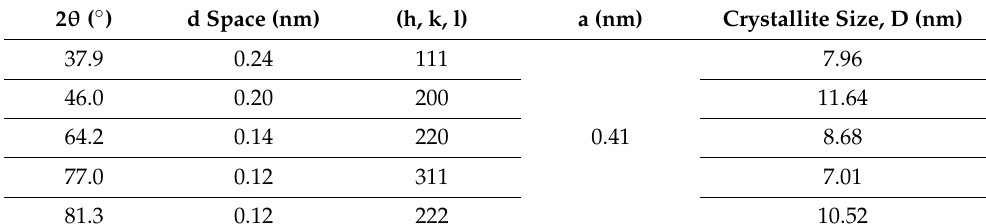
Table 1. XRD crystallographic data of the AP-AgNPs.